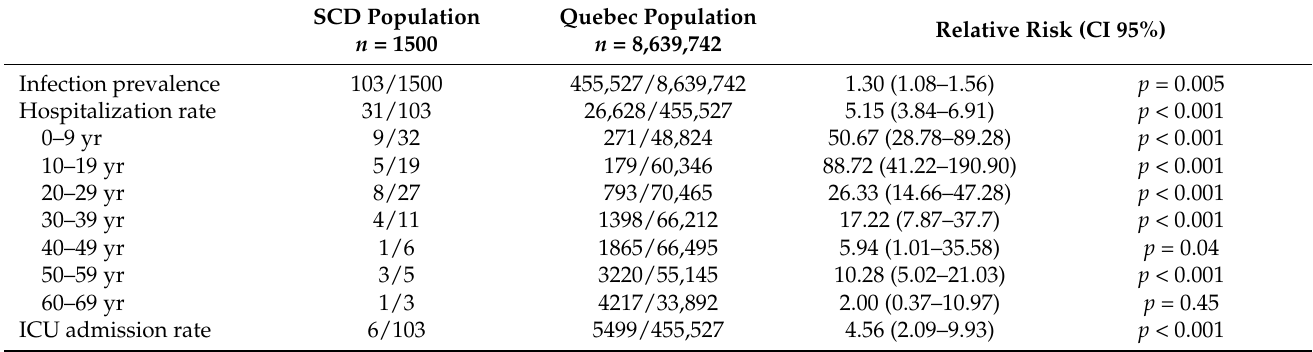
Table 5. Rates of infection, hospitalization, and ICU admission compared to the general population of Quebec,